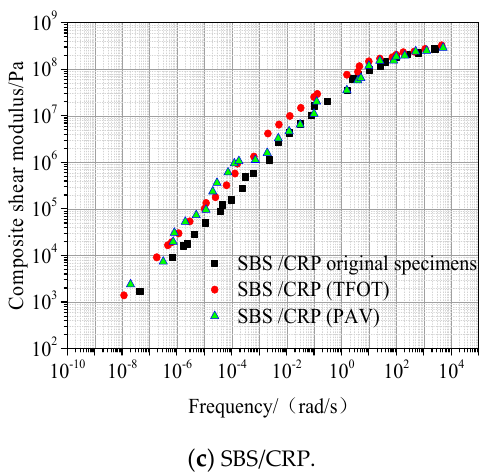
Figure 3. Master curve of composite shear modulus of asphalt: ( a ) SK90; ( b ) SBS; ( c ) SBS/CRP.